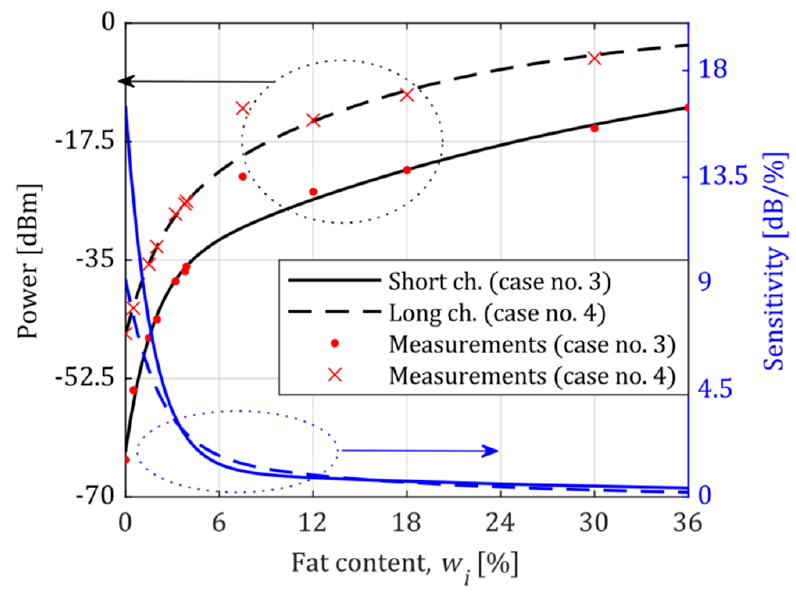
Figure 8. The standard curve and sensitivity curve for the fat content of milk. The system’s operating point was set at 0% of the milk fat.